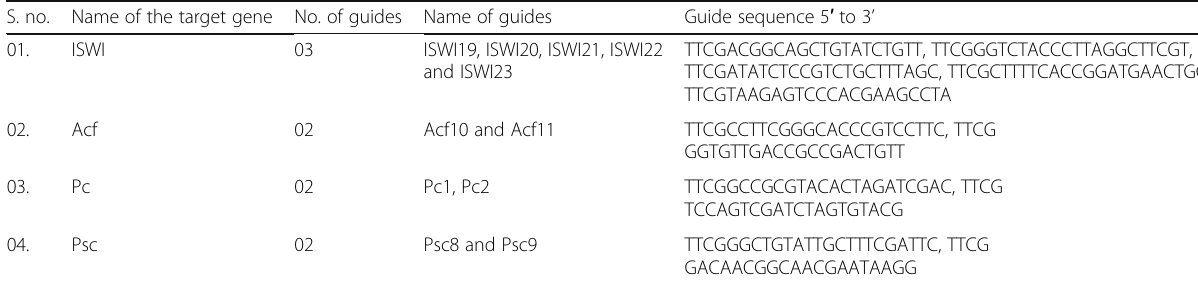
Table 1 Guide sequences of genes under study S. no. Name of the target gene No. of guides Name of guides Guide sequence 5 ′ to 3 ’